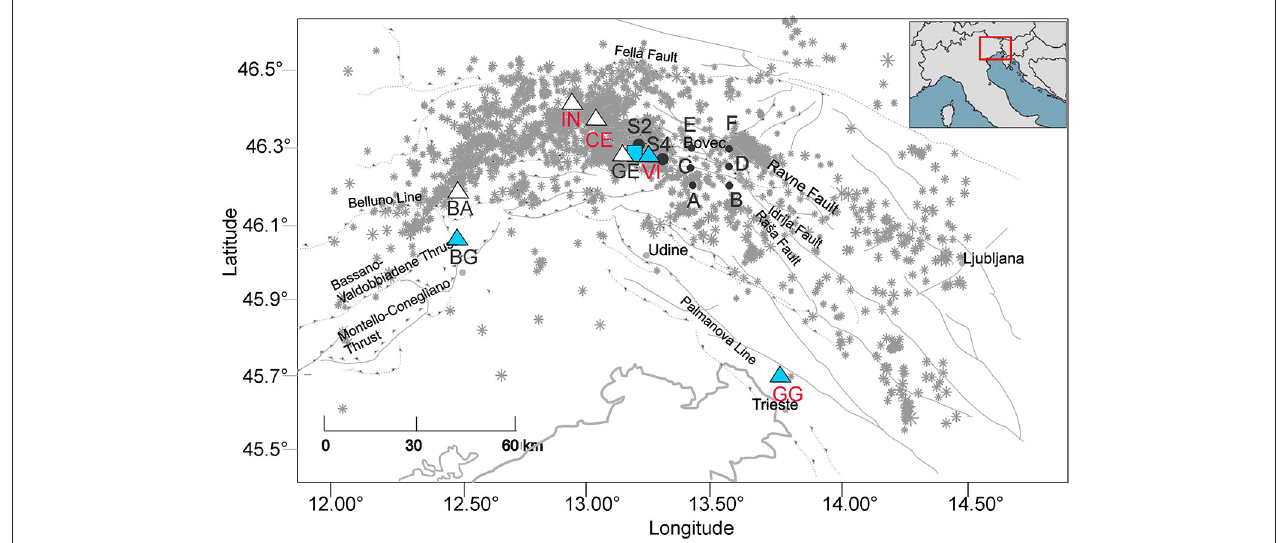
FIGURE 3 | Map with the principal tectonic lineaments and the NE-Italy subsurface tilt and strainmeter network sites: red labels, the sites considered in this study. Blue square: the strainmeter station, presently active; blue triangles: the stations currently active; white triangles: the sites active in the interval 1977–1996. S2, S4 : location of the vertical profiles from Faccenda et al. (2007); A,B,C,D,E,F : location of the six vertical profiles extracted from the model of Bressan et al. (2012). Inset: the location of the region of study. Gray stars: earthquakes recorded in 1988–2012 by the National Institute of Oceanography and Applied Geophysics-OGS seismometric networks (NI doi: 10.7914/SN/NI with University of Trieste, and OX doi: 10.7914/SN/OX; Bragato et al.,